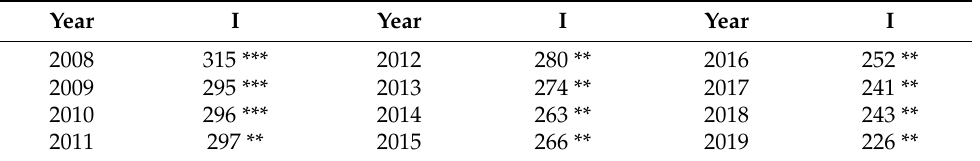
Table 4. Global Moran’s index CO 2 under spatial distance weight matrix.